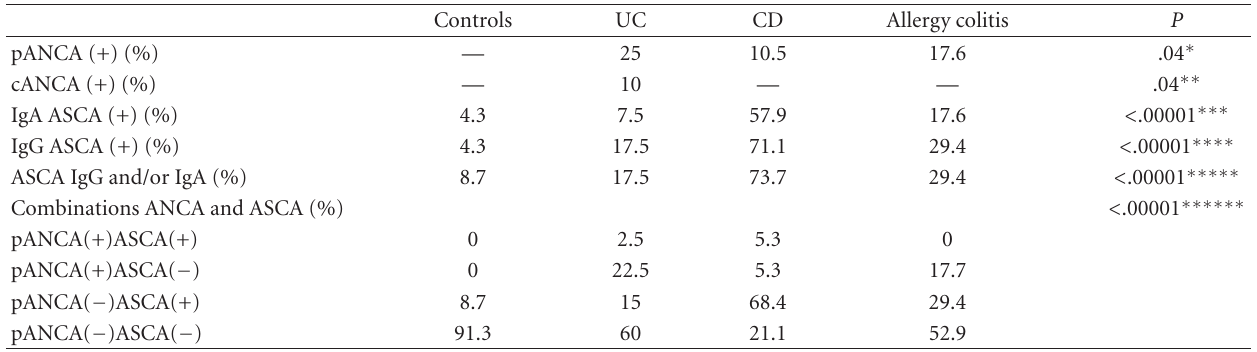
Table 2: Comparison between the frequency of occurrence of ANCA and ASCA antibodies in groups. Controls